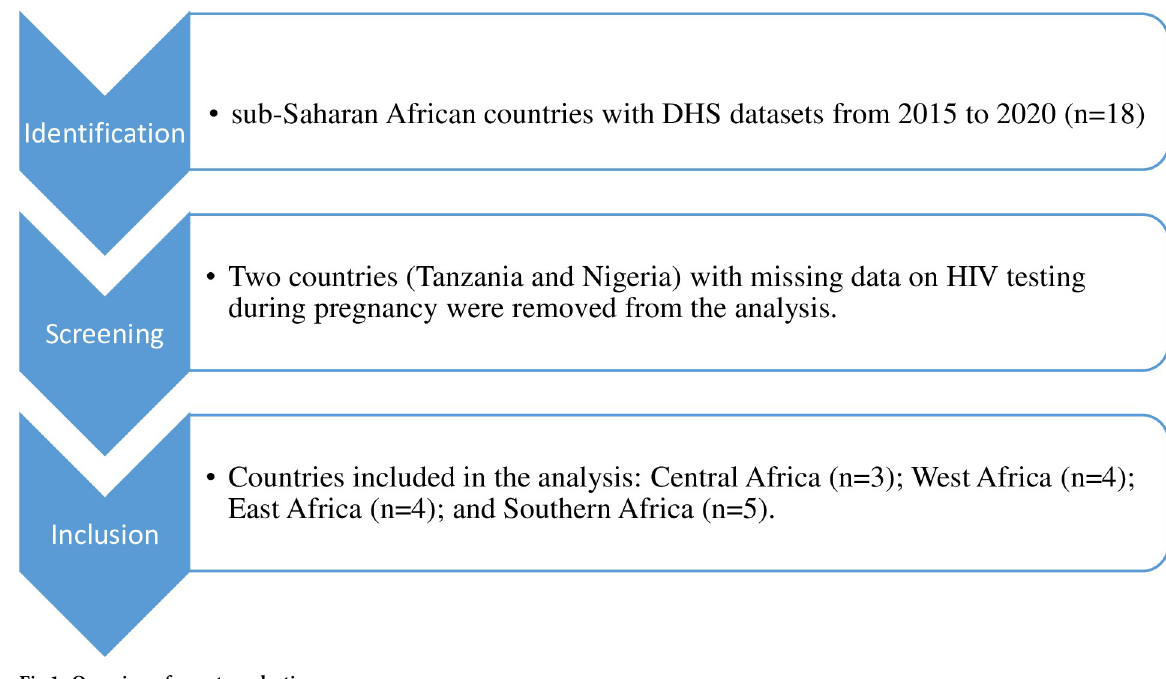
Fig 1. Overview of country selection.